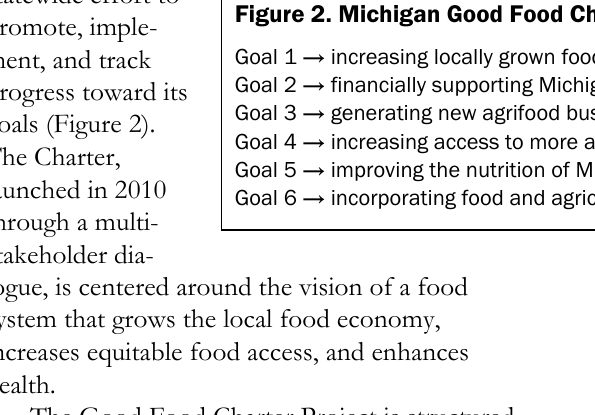
Figure 2. Michigan Good Food Charter Goals